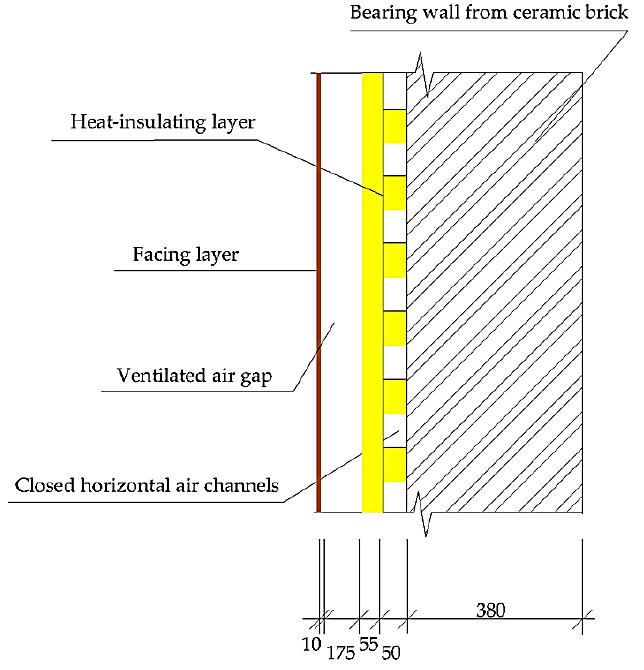
Figure 5. multilayer wall enclosing structure with a homogeneous bearing layer and a heat-insulating plate layer with horizontal air channels (the thickness of the layers of the structure is given in millimeters).